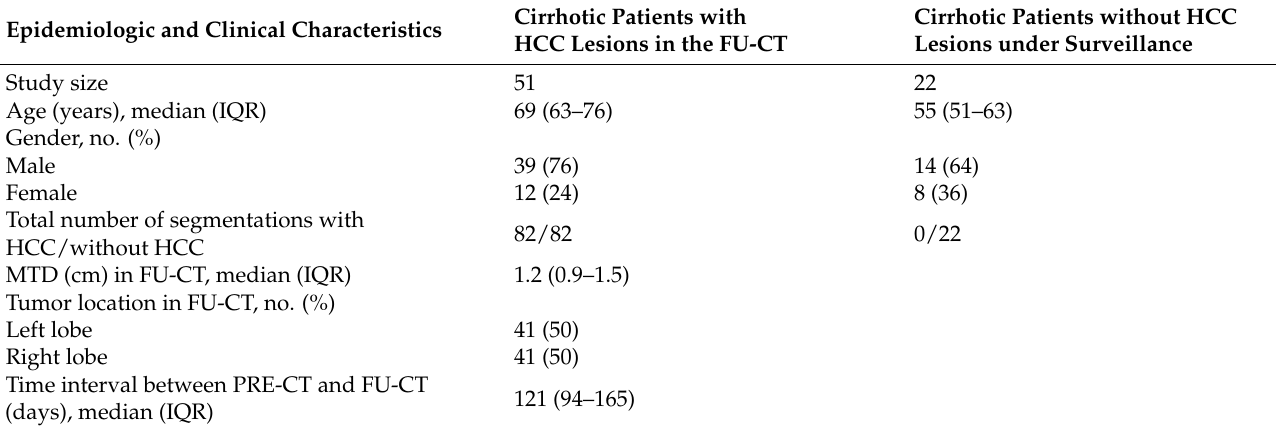
Table 1. Epidemiologic and clinical characteristics. IQR—interquartile range, MTD—median tumor diameter, HCC—hepatocellular carcinoma, PRE-CT—computed tomography prior to detection of a newly emerged HCC, FU-CT—follow-up computed tomography at the time of detection of a newly emerged HCC.